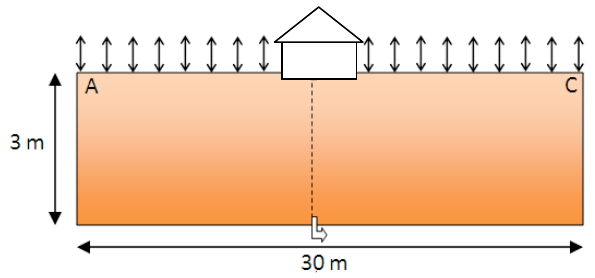
Fig. 4. Configuration used to analyse the influence of the presence Figure 4. Configuration used to analyse the influence of the presence of the structure on the of the structure on the soil-atmposphere exchange. soil-atmposphere exchange Figure 5c. Specific heat (Case Study) Fig. 5c. Specific heat (Case Study). Figure 5c. Specific heat (Case Study)